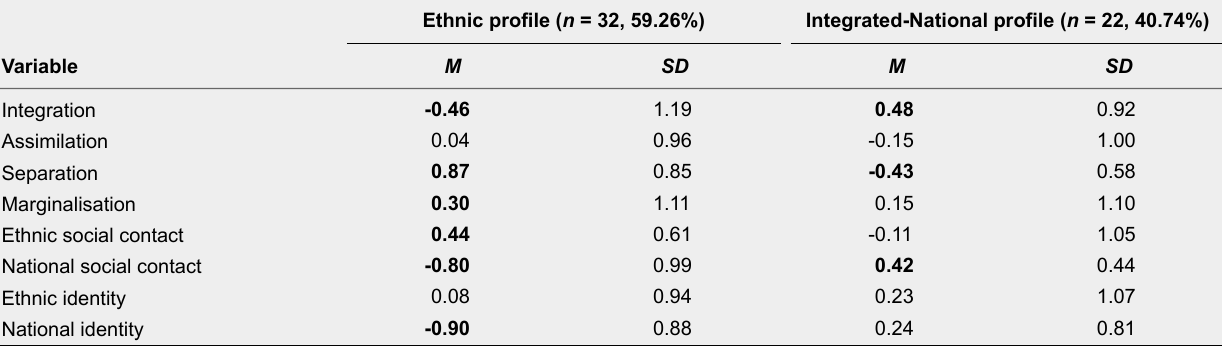
Means and Standard Deviations of Tunisian Acculturation Variables (Z-Scores) by Configuration in First-Generation Immigrant Adolescents (n = 54)